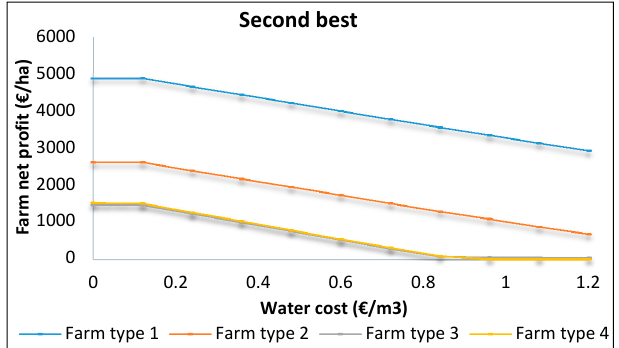
Figure 3. Farm net profit under first best water pricing scenario.